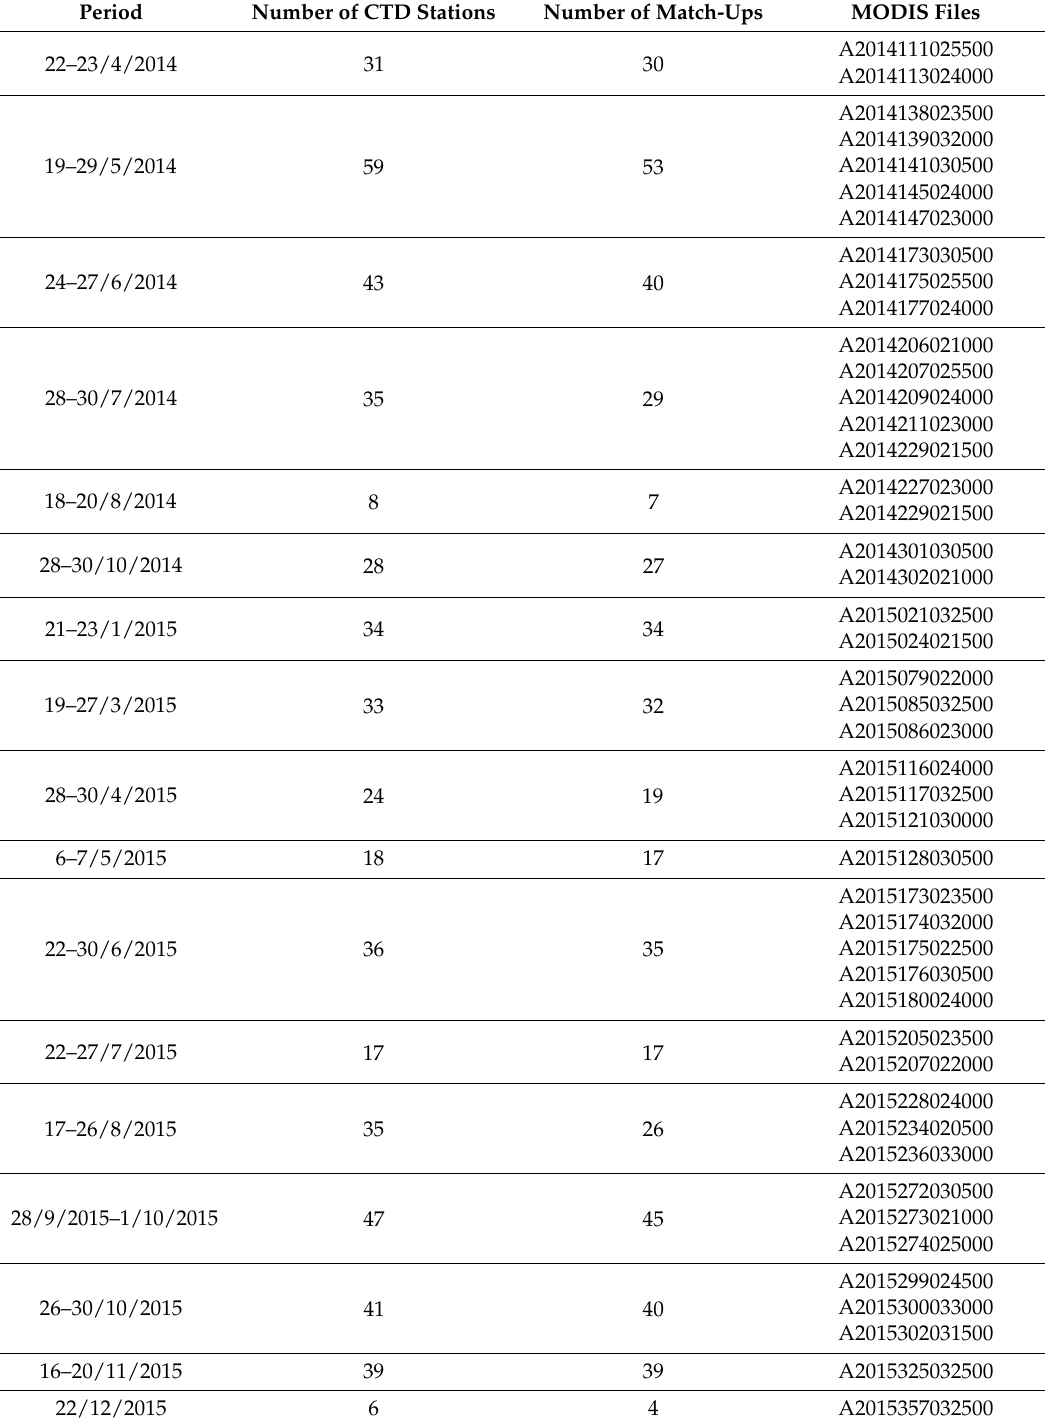
Table 1. Campaigns periods, number of match-ups per period and corresponding MODIS